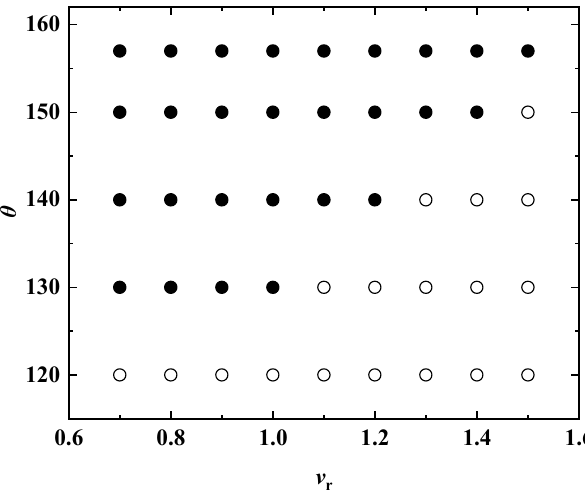
Figure 9. Map for outcomes of two successive droplets impacting with various velocity ratios and the surface with various contact angles. The solid symbols represent that the coalesced droplets rebound from the surface, whereas the empty ones are not.